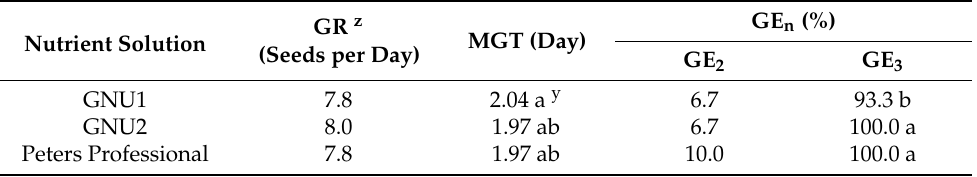
Table 1. Germination rate (GR), mean germination time (MGT), and germination energy (GE) of Ssamchoo as affected by nutrient solutions in the experiment